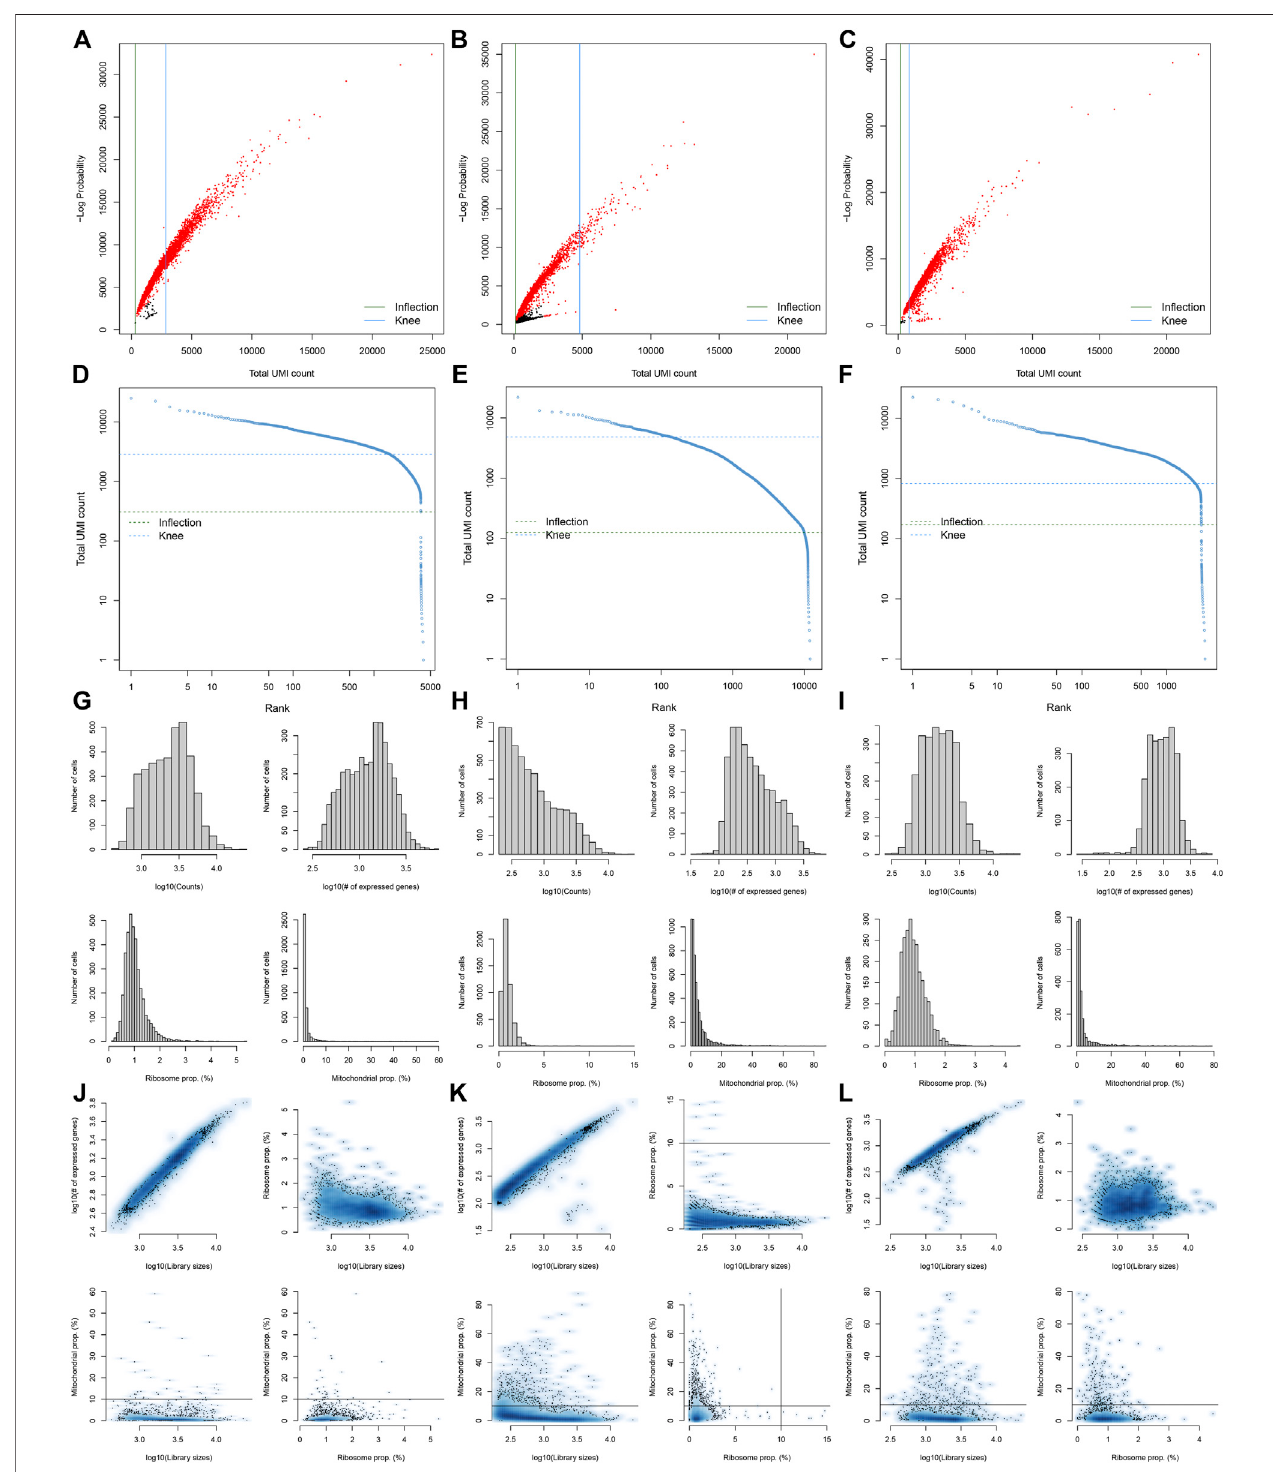
FIGURE2| Pre-processing,qualitycontrol,andnormalizationofscRNA-seqdataofthediabetickidneyspecimens. (A – C) Thetotalcountagainstthenegativelog- probability in the three diabetic kidney specimens. Red indicated cell droplet and black indicated empty droplet. (D – F) Barcode rank plots in the three diabetic kidney specimens. The in fl ection points of the knee indicate the transition of the total count distribution. (G – L) The ratios of mitochondrial and ribosomal genes expressed in each cell of the three diabetic kidney specimens.